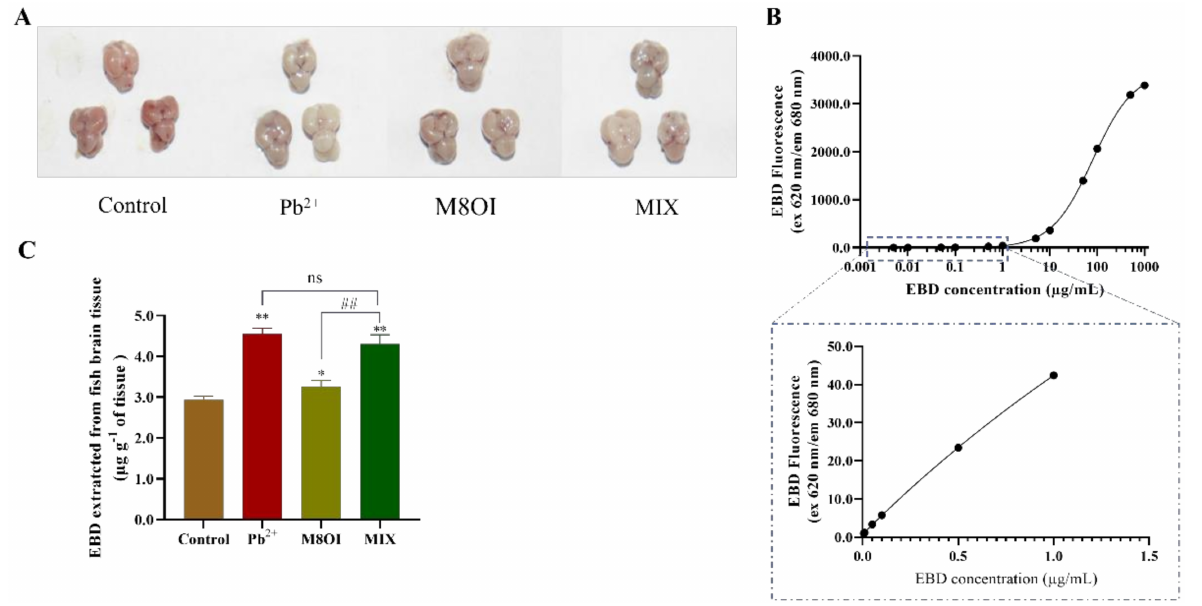
Figure 4. The fish BBB permeability assayed using EBD fluorescence method. ( A ) The representative pictures of EBD accumulated in brain of fish ( B ) The standard curve of EBD fluorescence was per- formed with 30 µ L dye in 50% TCA diluted to 120 µ L with 95% ethanol ( n = 5). ( C ) The quantification and visualization of EBD content in brain on day 28 under different exposures. Data are represented as mean ± SEM. * p < 0.05 and ** p < 0.01 are expressing the difference levels between control and exposure groups. ## p < 0.01 is expressing the difference levels between co-exposure and single exposure groups, and “ns” represents not